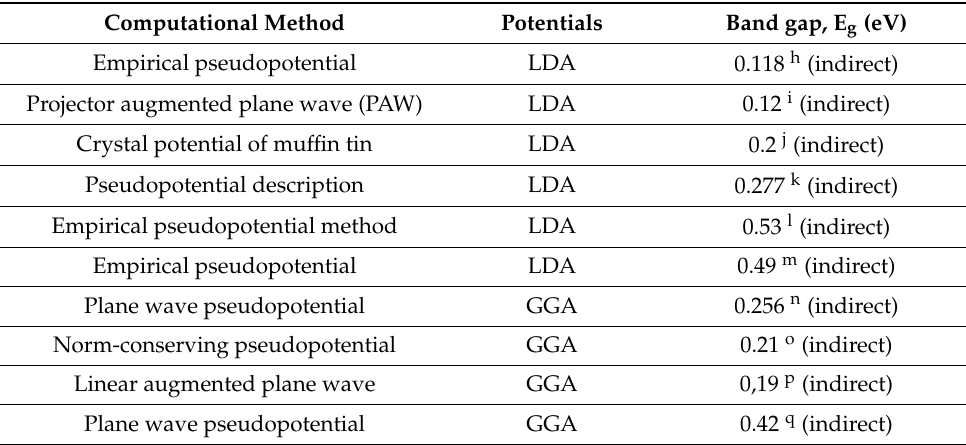
Table 2. Previous calculated band gaps of Mg 2 Si, mostly obtained with ab initio LDA or GGA